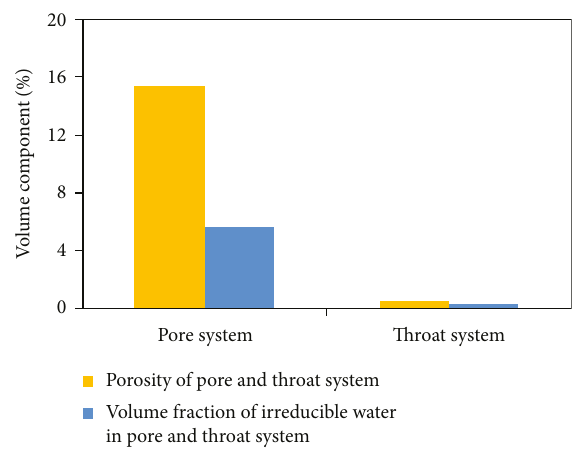
Figure 13: Histogram of irreducible water void space in the pore and throat